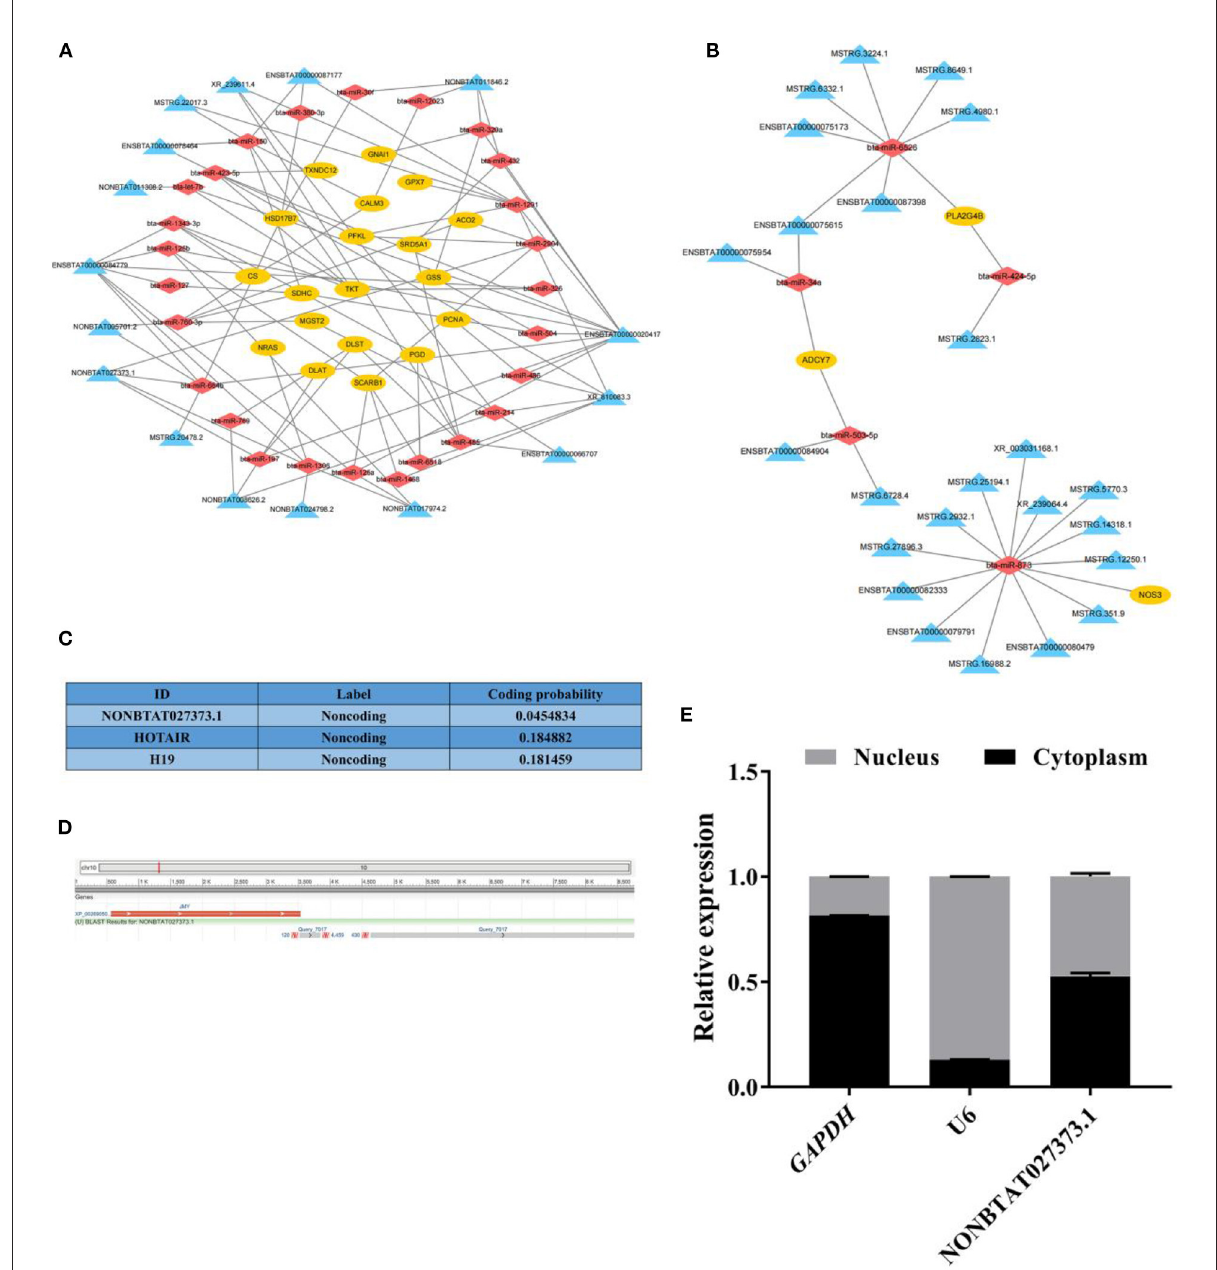
FIGURE4 The network analysis of lncRNA-miRNA-mRNA and the basic information of lncRNA NONBTAT027373.1. (A) : The lncRNA-miRNA-mRNA networks of DE mRNAs downregulated in cystic follicular GCs. (B) : The lncRNA-miRNA-mRNA networks of DE mRNAs up-regulated in cystic follicular GCs. (C) : The coding potential of lncRNA NONBTAT027373.1 and other RNAs predicted using computational approaches. (D) : The sequence alignment of lncRNA NONBTAT027373.1. (E) : The expression of lncRNA NONBTAT027373.1 in GCs nucleus and cytoplasm. Yellow nodes represent mRNAs; red nodes represent miRNAs and blue nodes represent lncRNAs in the networks of lncRNA-miRNA-mRNA.